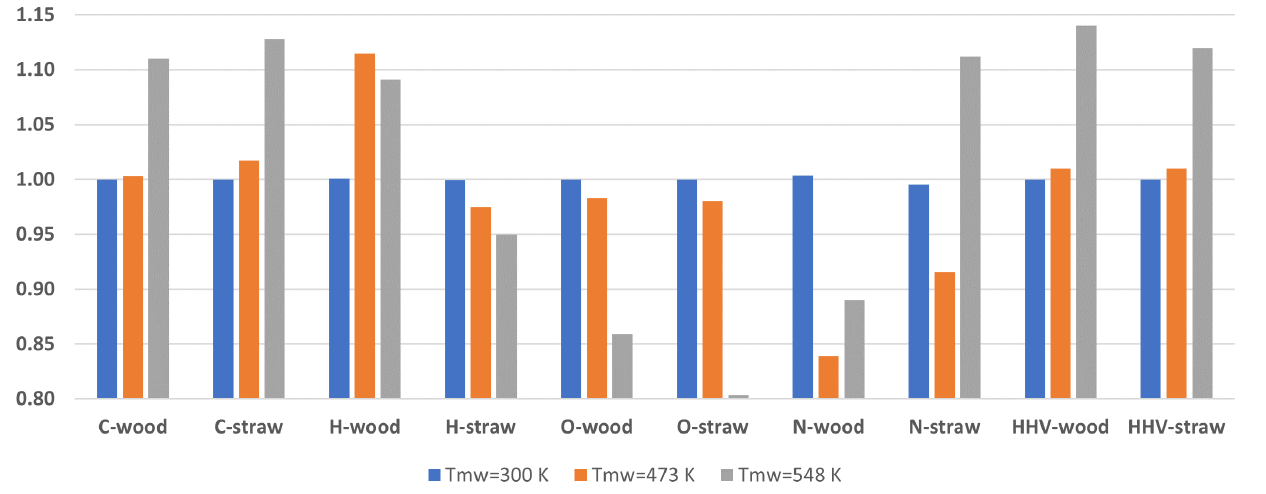
Figure 1. Relative effect of the MW pre-treatment temperature on elemental composition and HHV of the biomass pellets. of the biomass